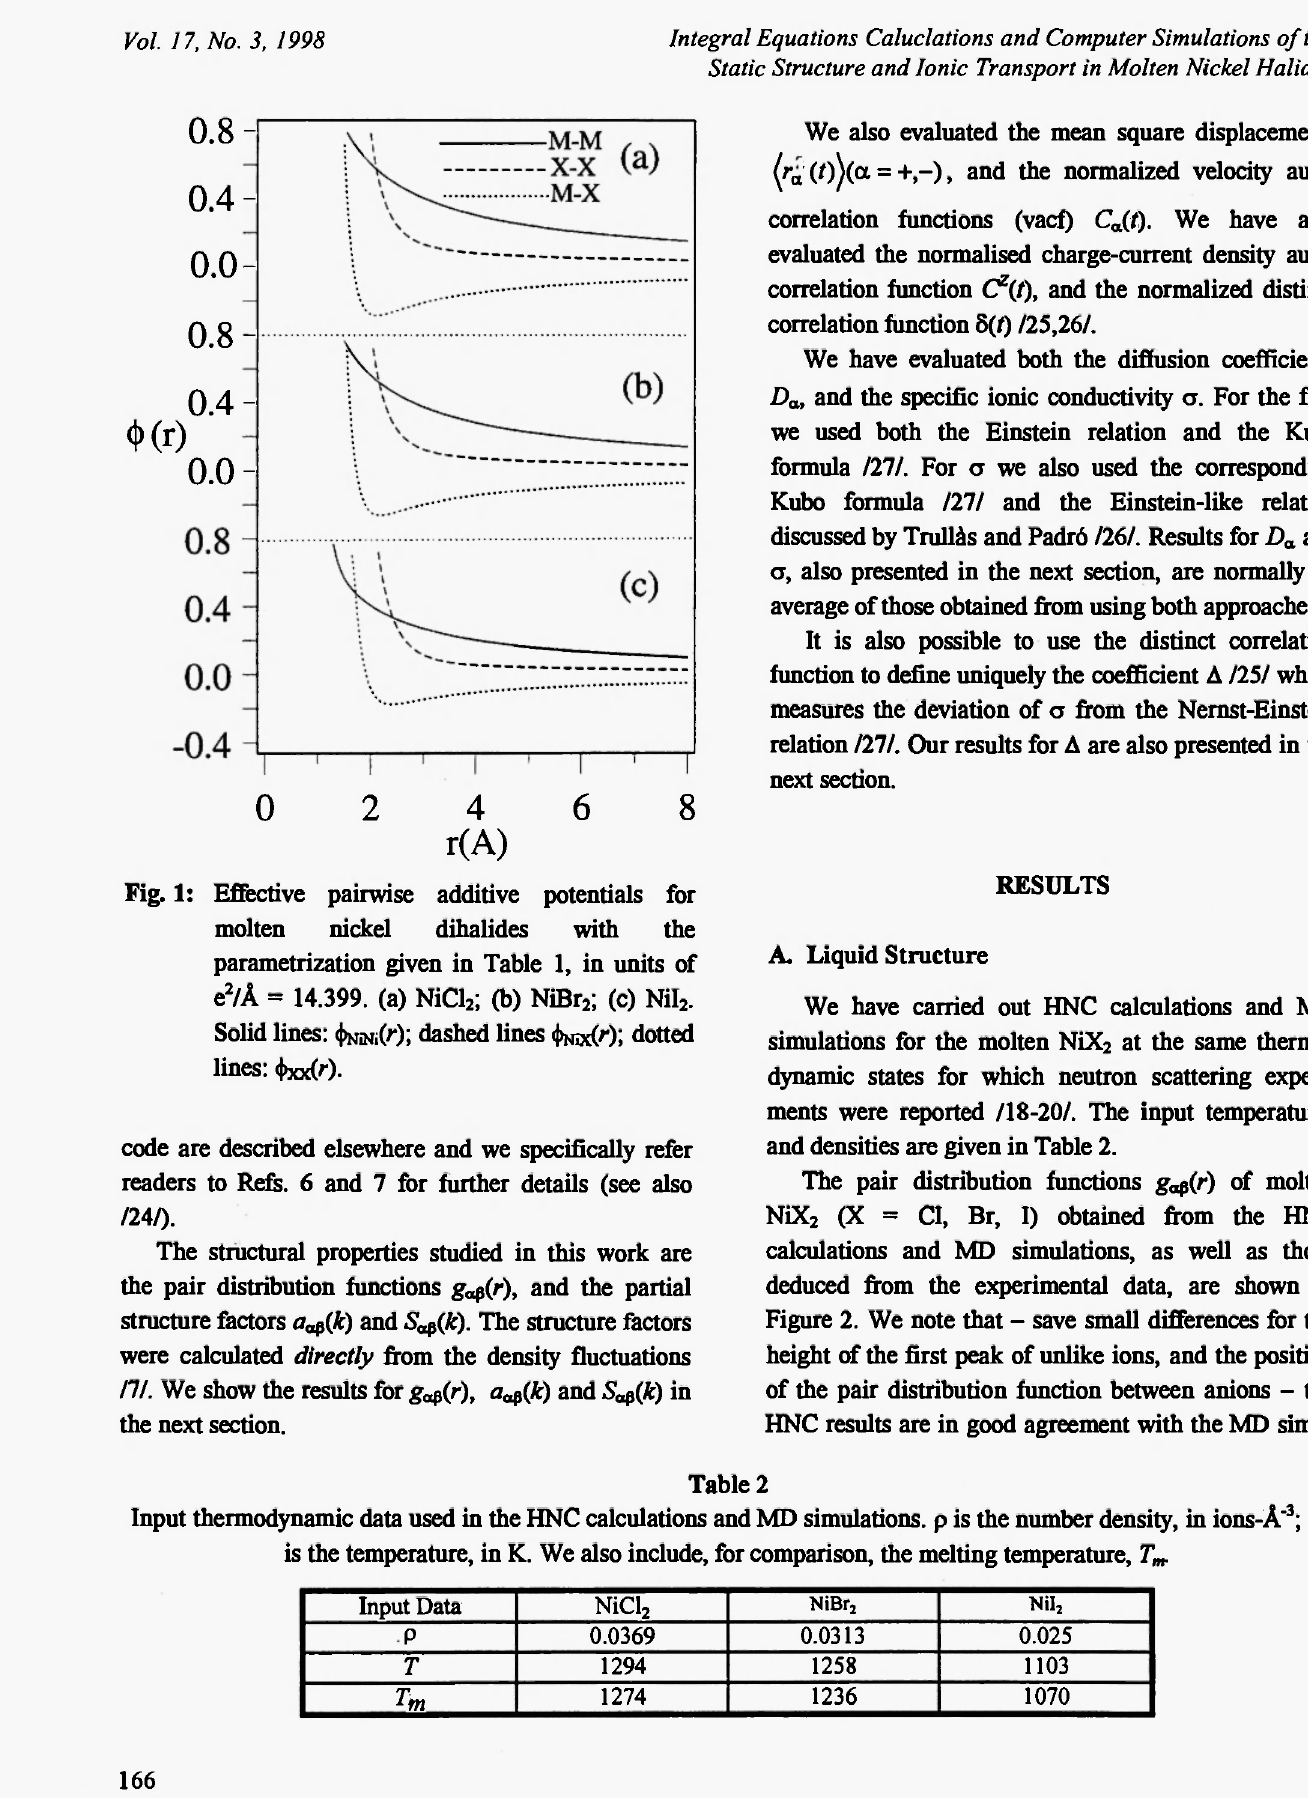
Input thermodynamic data used in the HNC calculations and MD simulations, ρ is the number density, in ions-Ä" 3 ; Τ is the temperature, in K. We also include, for comparison, the melting temperature, T